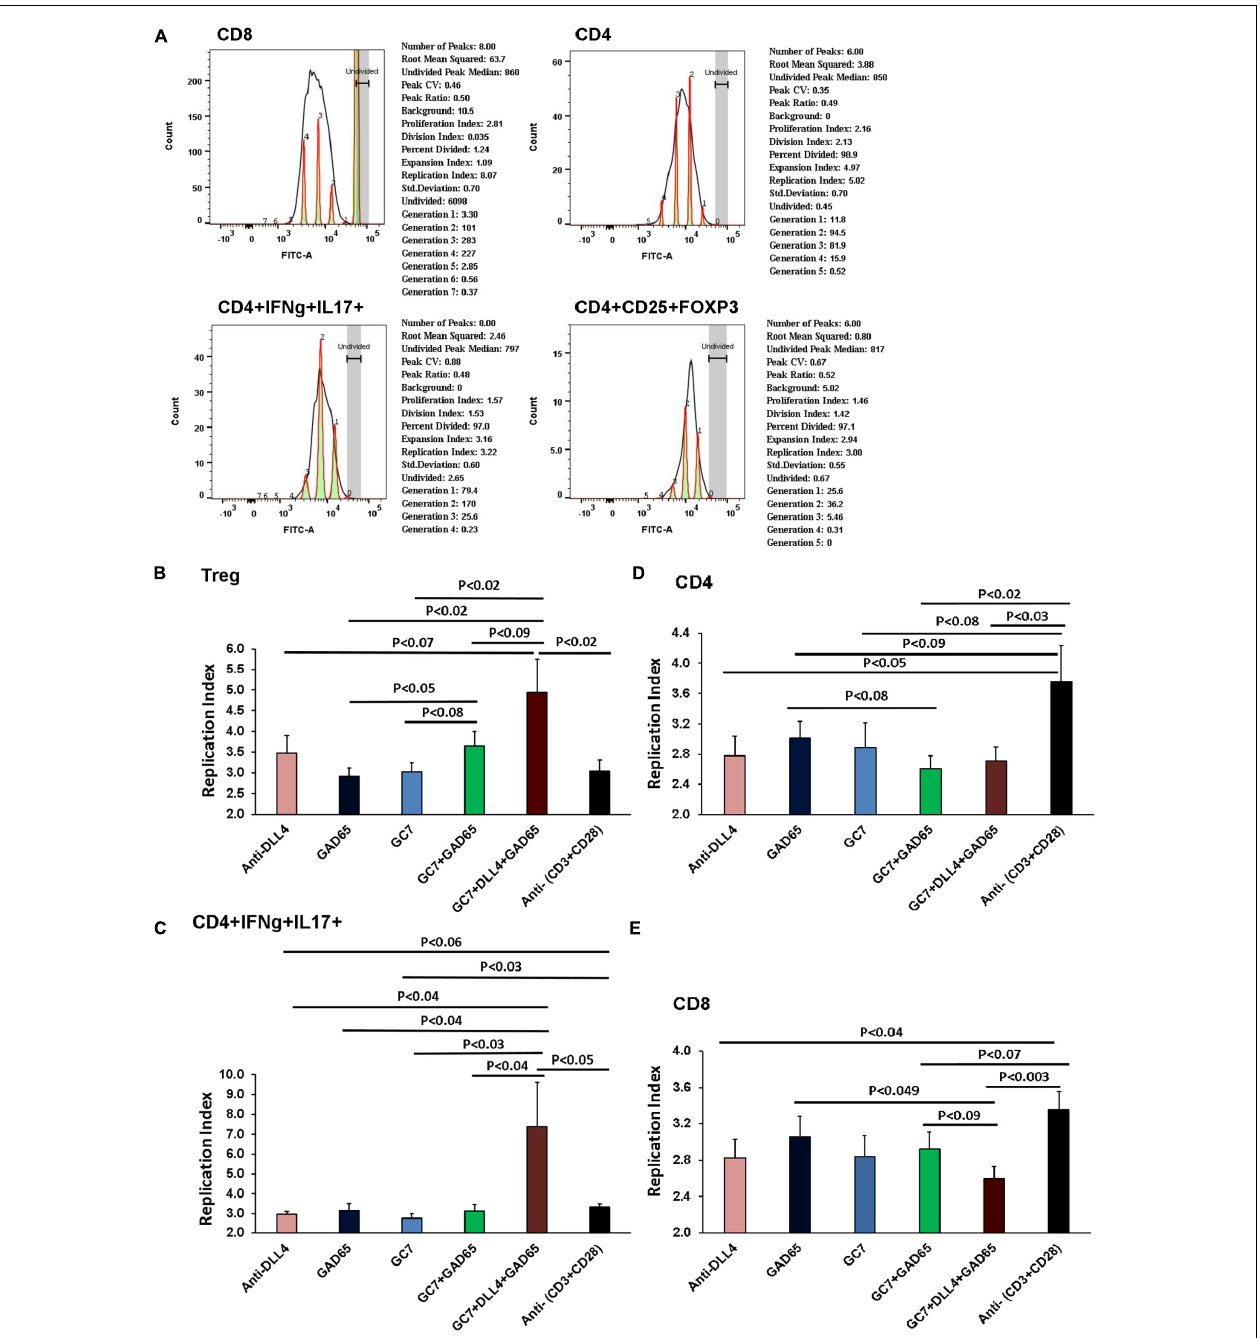
FIGURE 7 | Replicative index of T cells after In vitro co-stimulation. Purified CD4, CD8 and CD25 were isolated from T1D mice PLNs using mice CD4, CD8 and Regulatory T Cell Isolation Kit (# 130-104-454). All T cell groups were incubated in CellTrace (CFSE-FITC, x -axis). Each sample was co-cultured in triplicate ( n = 8 animal per group). Histograms show replication index as analyzed by using FLOW JO_V10 proliferation assay software (A) . Graph summarizes data of in vitro proliferation assay from above flow data. As shown, the proliferative capacity of T cells was determined by analyzing the replication of different cell types under different co-culture conditions. Replicative index of CD4, CD8, CD4 + IFNg + IL17 and CD4 + CD25 + FOXP3 cells were under in vitro co-stimulation conditions. Replicative index of Treg cells corresponded to the in vitro enrichment of Treg in anti-DLL4, GC7, GC7 + rhGAD65 and anti-DLL4 + GC7 + rhGAD65 treated groups (B) . We further investigated population of CD4 T cells showing plasticity toward Treg cells. Proliferative index of CD4 + IFNg + IL17 positive T cells was further analyzed using CFSE (FITC labeled) to track the individual proliferative cycle. Peak in the replicative index of CD4 + IFNg + IL17 positive T cells in anti-DLL4 + GC7 + rhGAD65 treated group was significantly higher (C) . Co-stimulation with anti-DLL4, GC7 + rhGAD65, anti-DLL4 + GC7 + rhGAD6 significantly reduced the CD4 count as compared to conventional stimulation with anti-(CD3 + CD28) (D) . Most interestingly, we also observed that co-stimulation with anti-DLL4 + GC7 + rhGAD65 significantly reduced the proliferation index of CD8 T cells (E) .